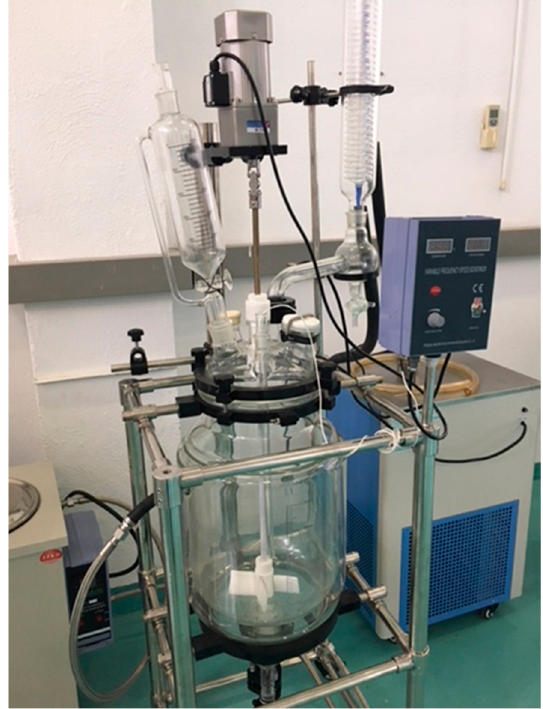
Figure 1. Pilot-scale reactor for the preparation of the M x O m @SiC core–shell nanomaterials.